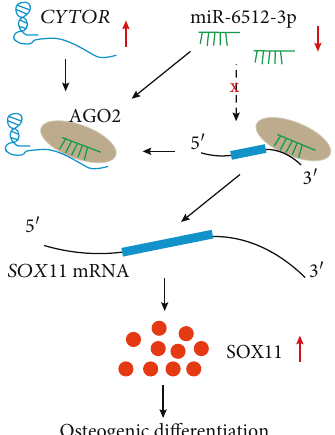
Figure 6: Schematic diagram of potential mechanisms involved in CYTOR -mediated osteogenic di ff erentiation of PDLSCs. CYTOR acted as a molecular sponge to restrain the bioactivity of miR- 6512-3p, resulting in increased miR-6512-3p targeting SOX11 expression, leading to the enhancement of osteogenic di ff erentiation of